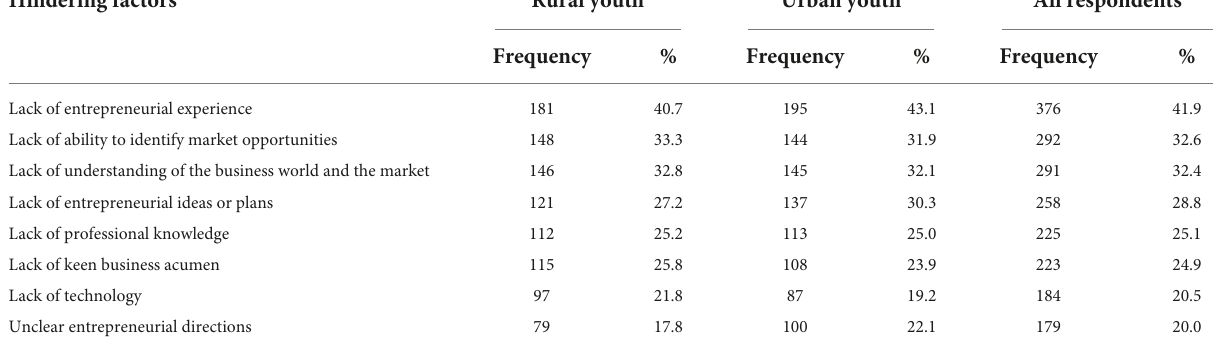
TABLE 4 Entrepreneurial experience and ability. Hindering